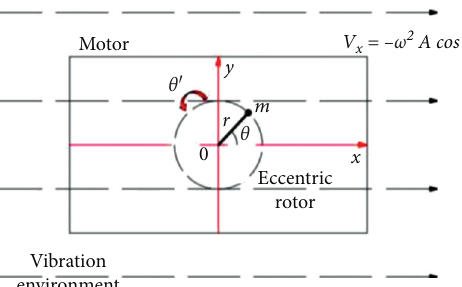
Figure 1: Dynamic model of the vibration system with electrically driven eccentric rotor in the vibration